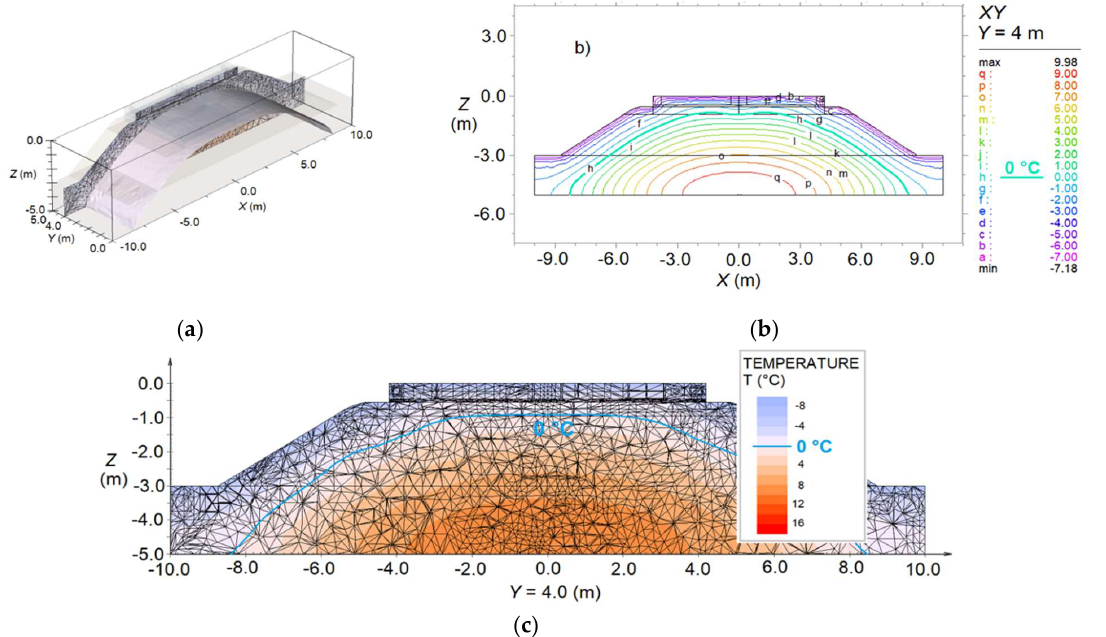
Figure 4. Graphic outputs Y = 4 m: ( a ) 3D view; ( b ) isotherms; ( b ) cross-section.